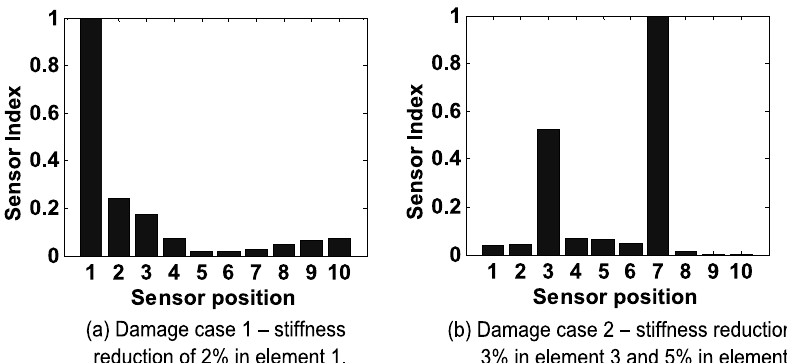
Fig. 2. Finite element model for the cantilever beam.